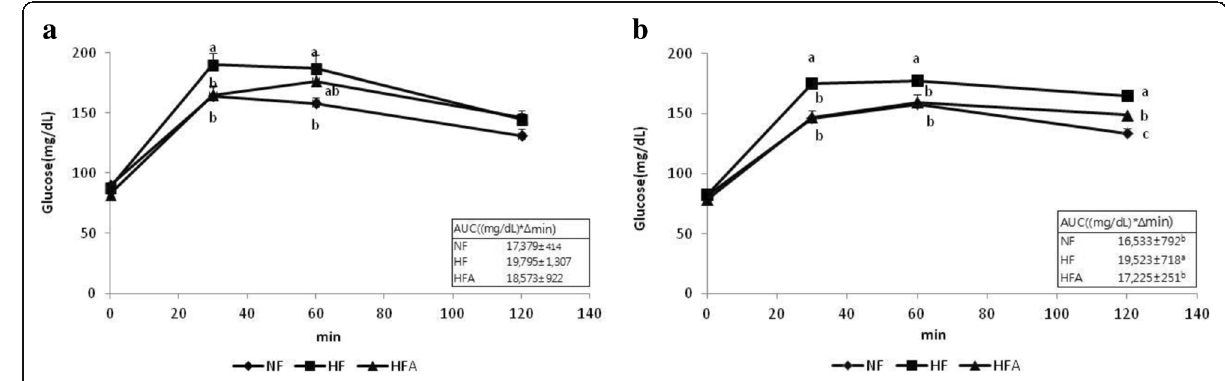
Fig. 1 Oral glucose tolerance test at ( a ) 5 and ( b ) 15 weeks. Data are expressed as Mean ± S.E. ( n = 9 – 10). Abbreviations: NF, normal-fat diet; HF, high-fat diet; HFA, high-fat diet with 0.1% Agrimonia pilosa aqueous extract. Values with different letters are significantly different ( p < 0.05) by Duncan ’ s multiple range test